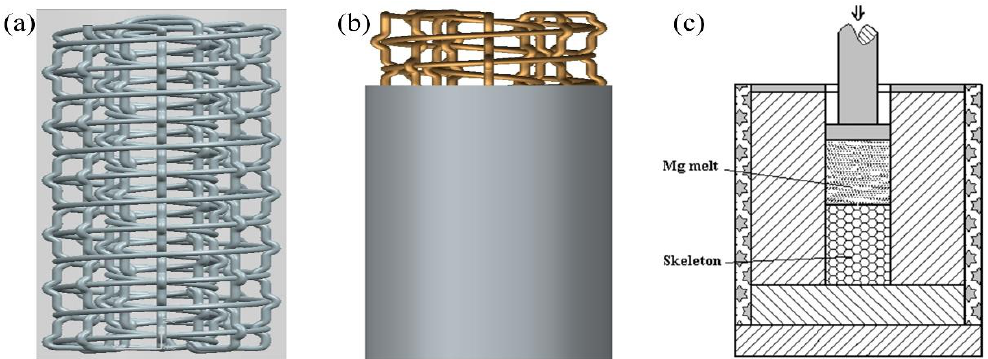
Figure 2. Three-dimensional model image and technical diagram: ( a ) reinforcement; ( b ) MIMC composites; ( c ) the pressure infiltration technology.